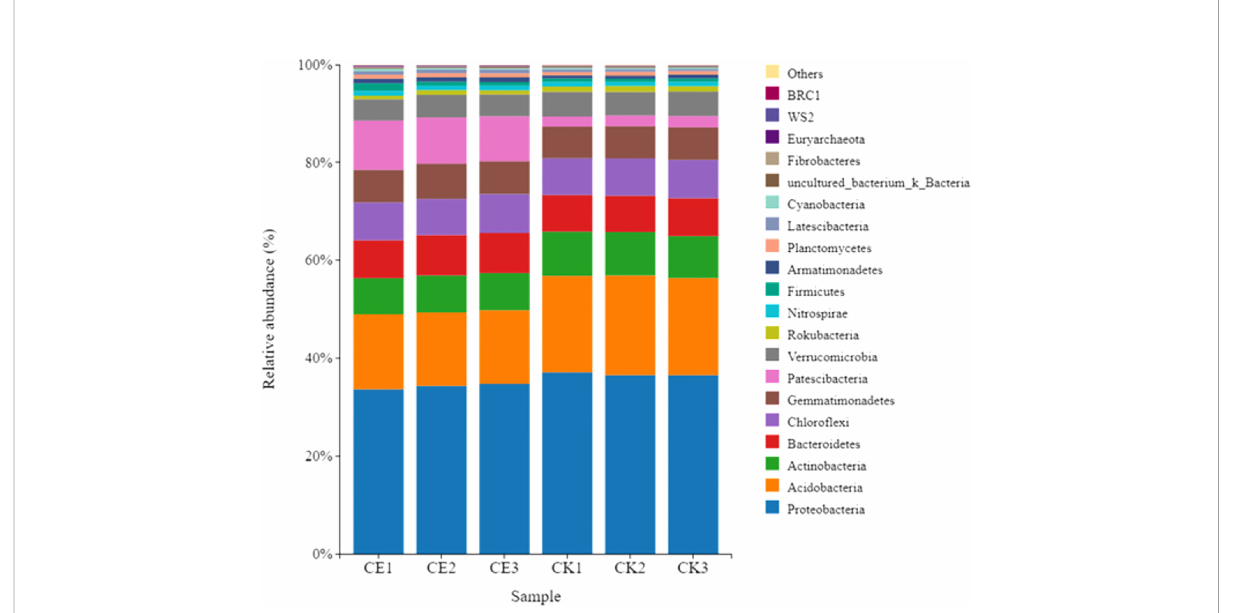
FIGURE 9 Differences in bacterial phylum level distribution in maize rhizosphere